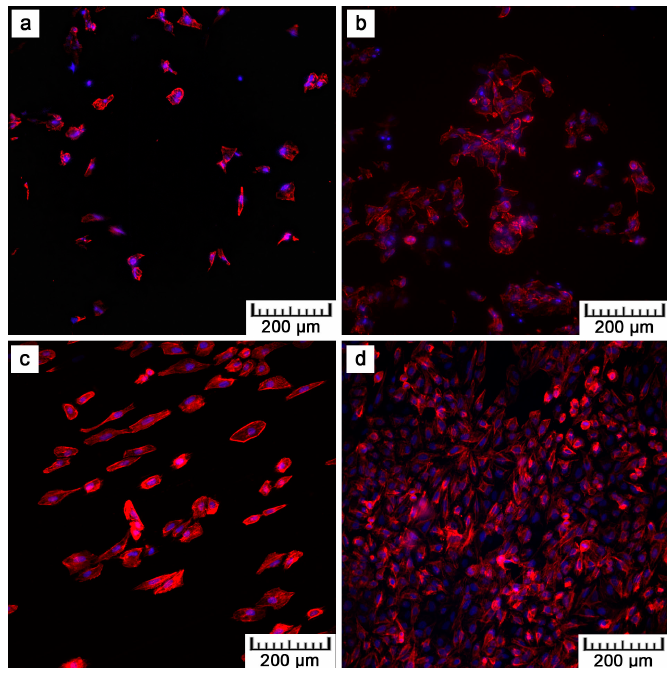
Figure 8. U-2 OS cells cultivated on : ( a , b ) the plasma-sprayed titanium; ( c , d ) ground Ti6Al4V for one (left images) and four (right images) days (red—F-actin, blue—nuclei, magnification 100×).